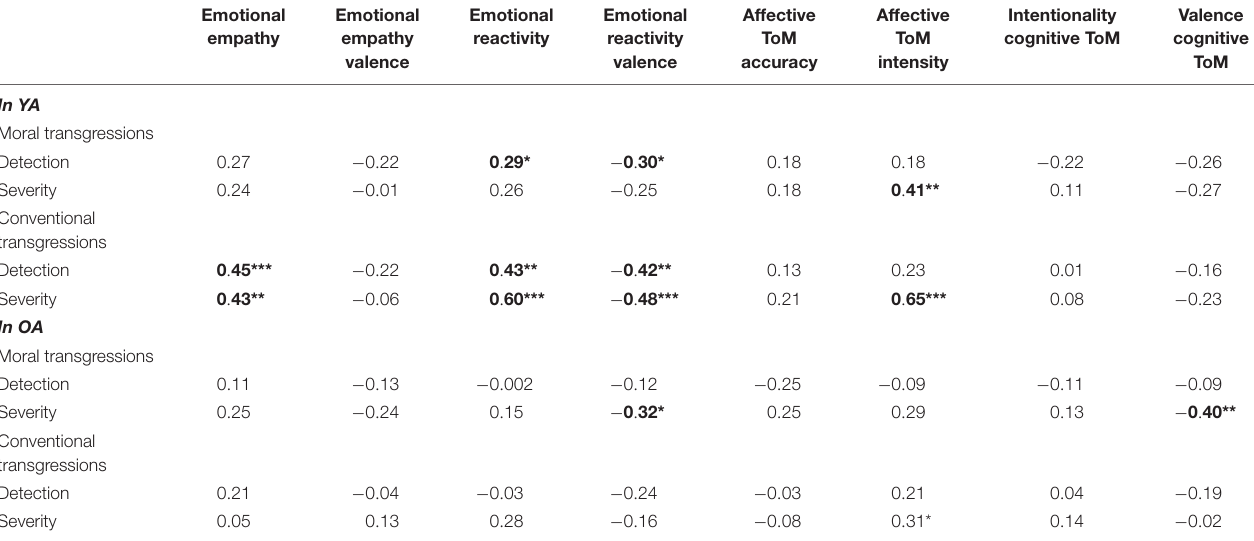
TABLE 4 | Correlations (Bravais-Pearson correlation coefficient) between transgression detection/severity and sociocognitive processes assessed during the REALSoCog task in young (YA) and older adults (OA). Emotional Emotional Emotional Emotional empathy empathy reactivity reactivity valence